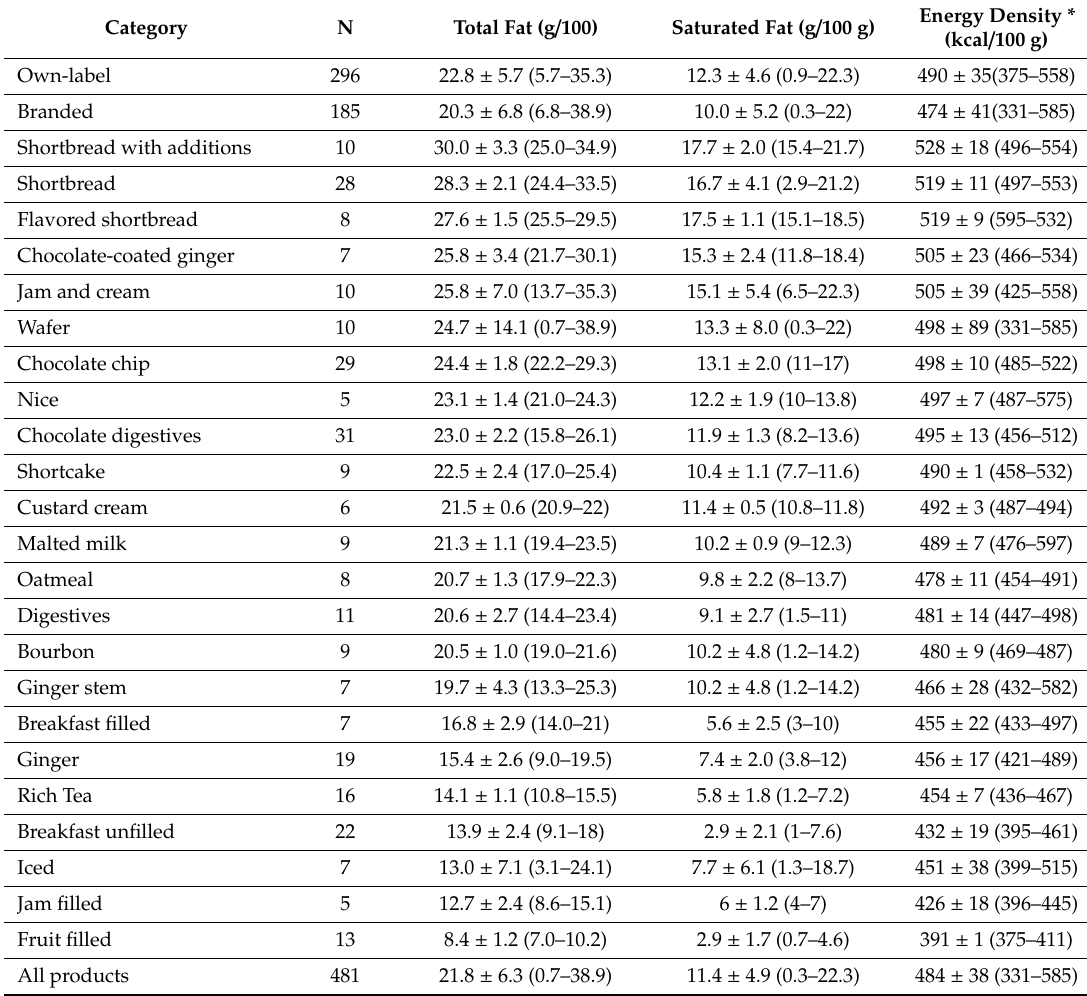
Table A2. Total and saturated fat content and energy density indi ff erent categories of biscuits, mean ± SD